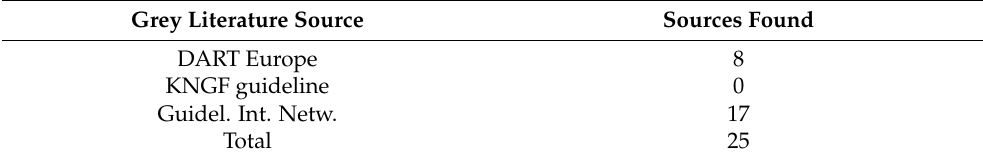
Table A2. Grey literature